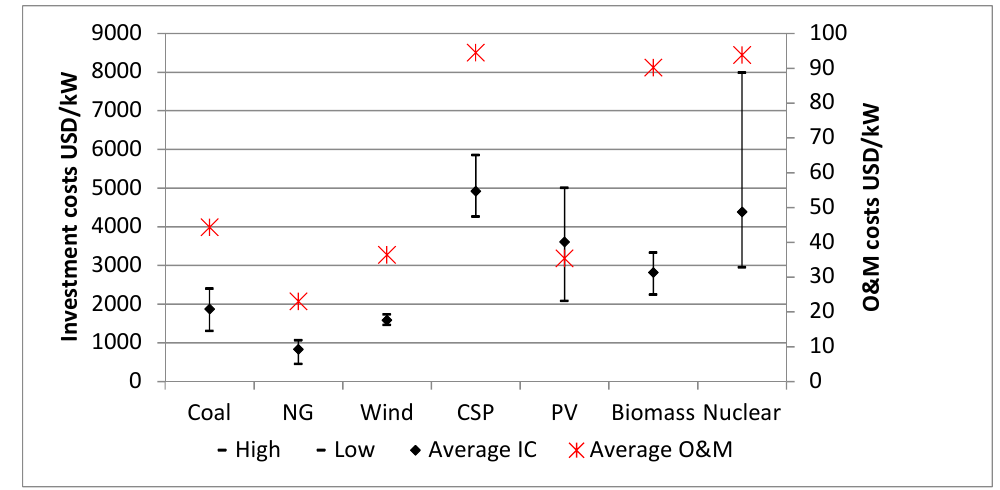
Figure 3. The investment costs and the operation and maintenance (O&M) costs of the assessed technologies [46,48,56,57].